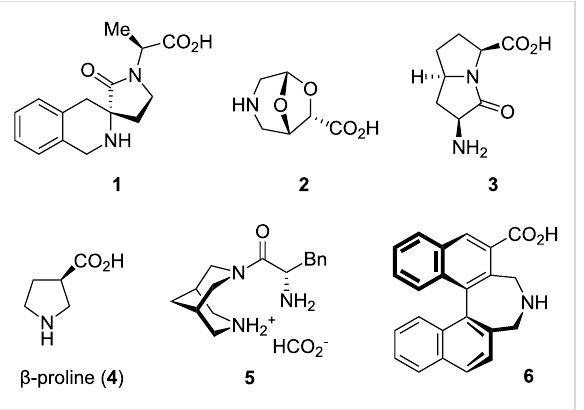
Figure 1: The conformationally rigid amino acid derivatives 1 – 3 (β-turn-inducing building blocks) and 4 – 6 (successful organocatalysts).